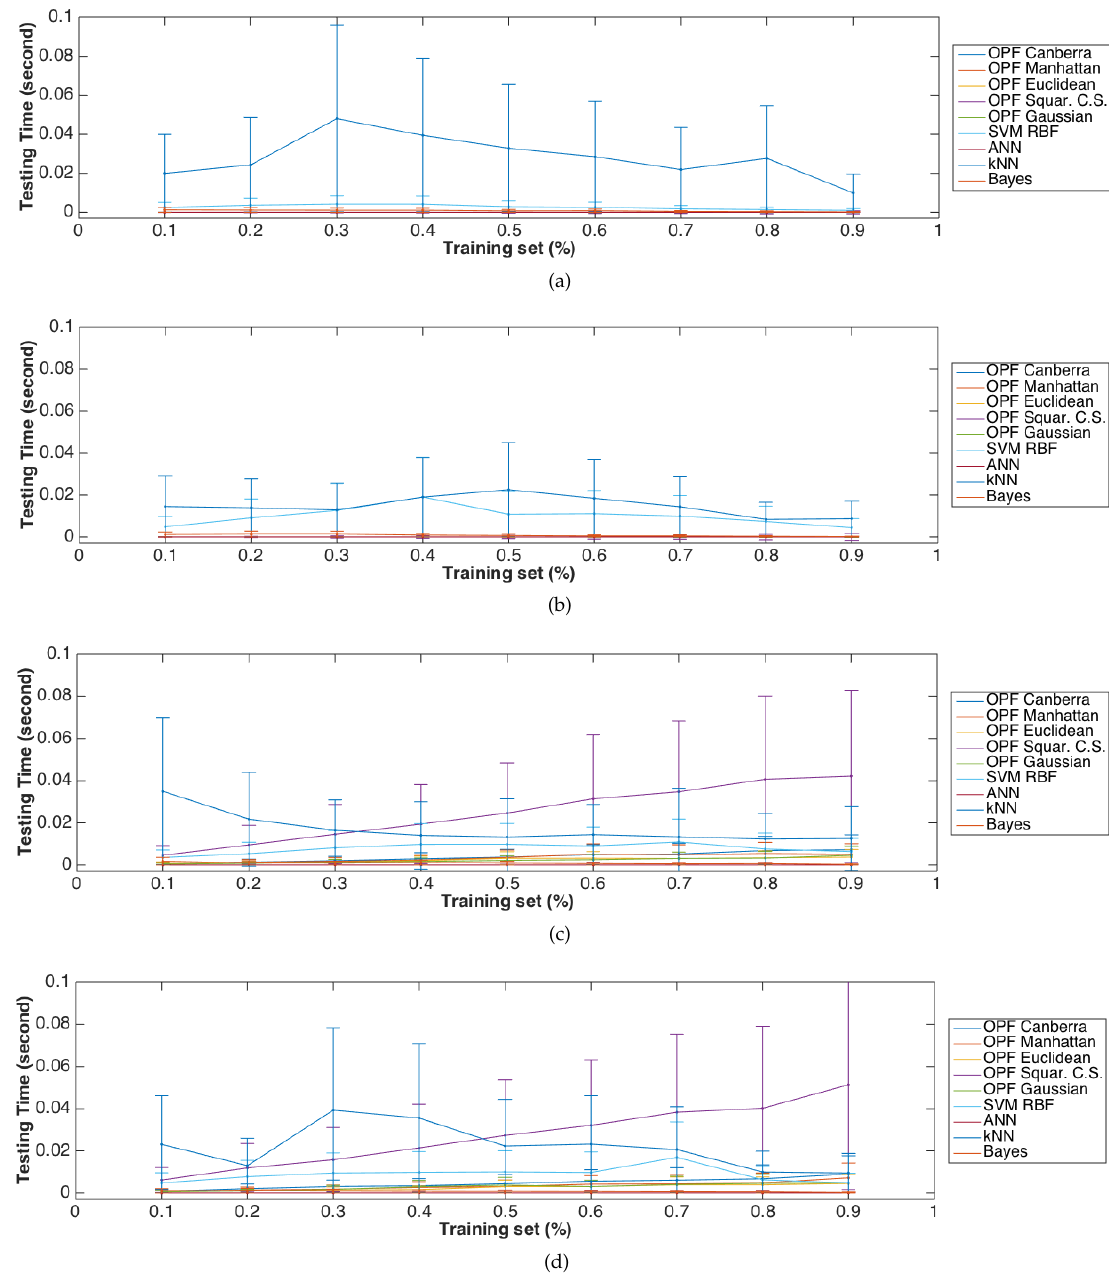
Figure 8. Testing time required by the computer classifiers varying the percentage of the used training data from 10 to 90% when applied on the original data and on the same data corrupted with the addition of Gaussian noise: ( a ) 0% (raw data); ( b ) 5%; ( c ) 15%; and ( d ) 25%. OPF classifier merits, like reduced training and testing times, observed in the classification results obtained from the original raw data, continued to be evident in the tests performed using the same data corrupted with Gaussian noise. In addition, it was clear that OPF classifiers were able to get very good accuracy rates, training and test times, independently of the used training data